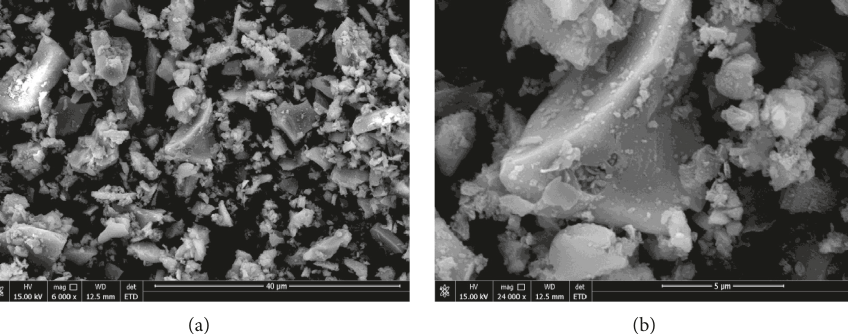
Figure 4: Microstructure of the ground RHA. (a) RHA particle at low magnification (6,000x); (b) RHA particle at magnification (24,000x).